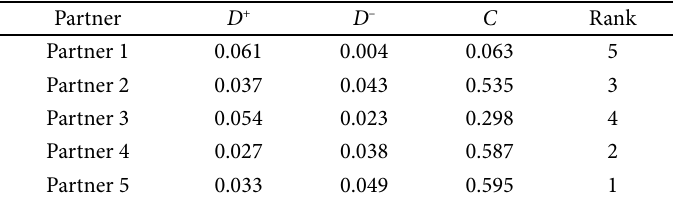
Table 16. The ideal solution and the rank of each alternative resulting from the Fuzzy TOPSIS method Partner D + D – C Rank Partner 1